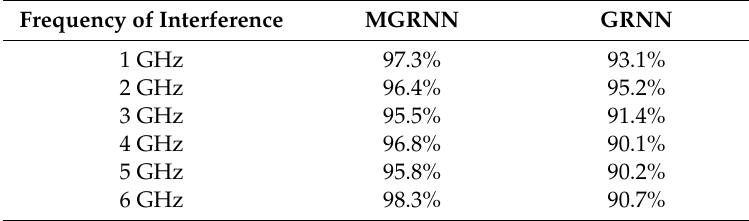
Figure 18. Clustering result. ( a ) K-means clustering; ( b ) modified K-means clustering. Table 2. Accuracy for classifying interference using MGRNN and